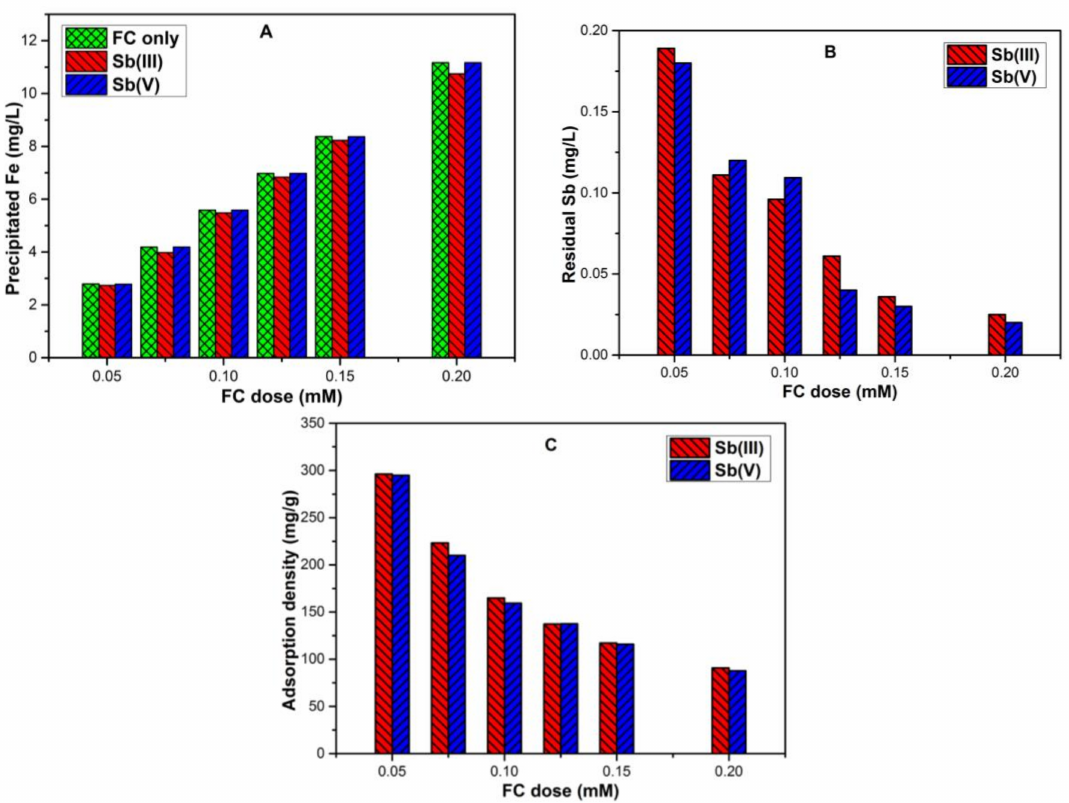
Figure 2. Across various FC doses of 0.05 mM to 0.2 mM (i.e., 13.51 mg/L to 54.06 mg/L), at pH 7, 1 mg/L initial Sb concentration and temperature T 25 ± 1 ◦ C showing ( A ) Fe precipitation (mg/L); ( B ) residual Sb (mg/L); ( C ) adsorption densities